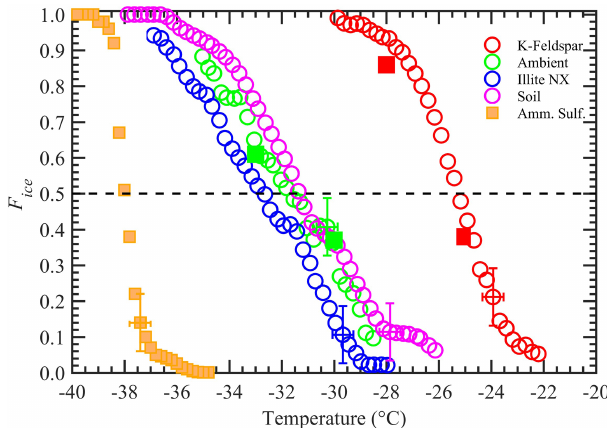
Figure 6. The F ice of four INP test species as a function of tem- perature. The vertical error bar represents the 1 standard deviation of the three repeat experiments ( n = 3). Temperature measurements had ± 0.4 ◦ C uncertainty. For clarity, error bars are shown for only one data point. Solid square orange markers represent the freezing temperatures of water droplets containing 1wt% AS. Other solid square markers represent data collected when the chamber was op- erated in a steady-state temperature mode (instead of steady cool- ing). The dashed horizontal line represents 50% F ice